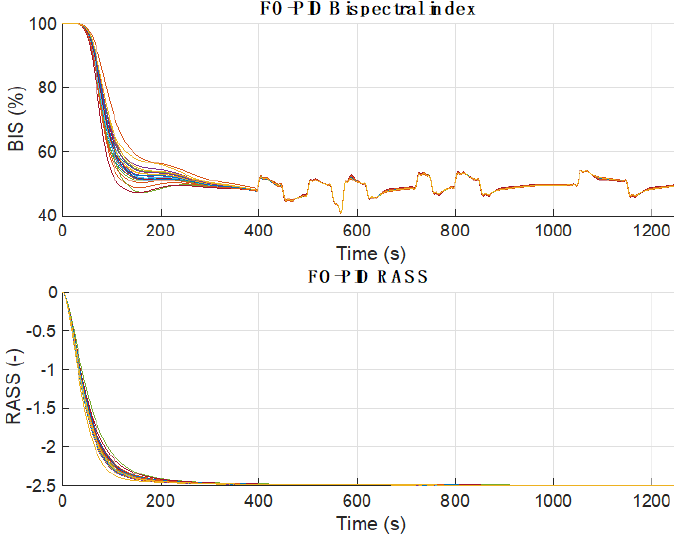
Figure 4. Induction-phase FOPID control of BIS and RASS—simulation results for 24 patients.